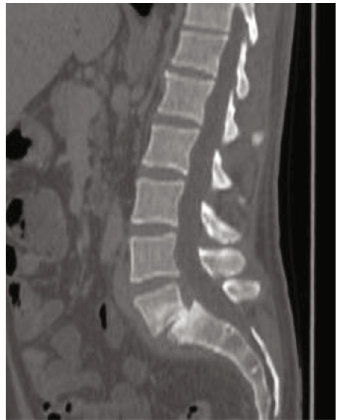
Figure 1: The lumbar spine in sagittal sections, highlighting an L5- S1 spondylolisthesis by isthmic